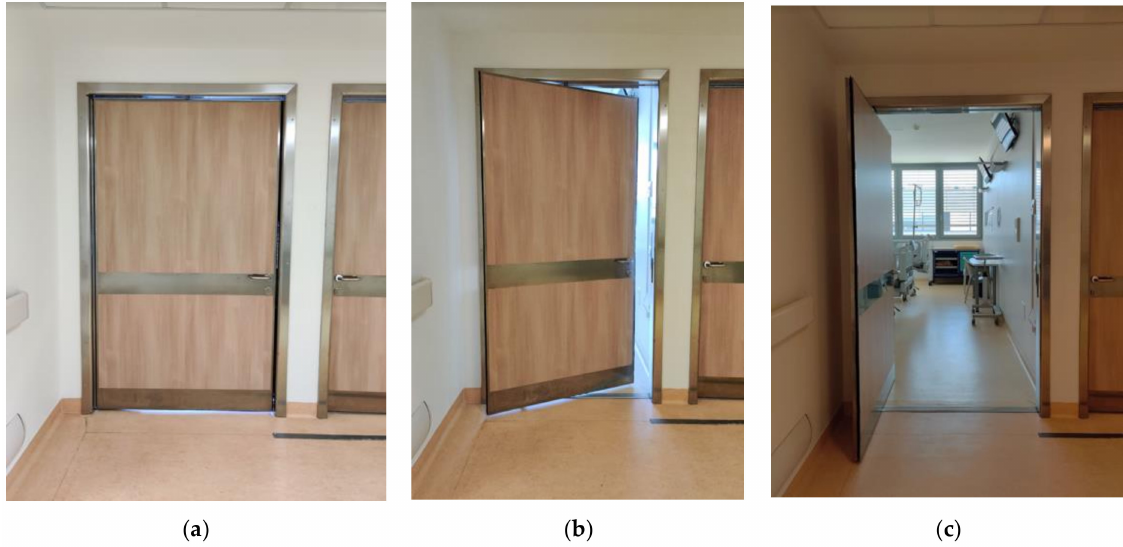
Figure 3. The three configurations of the door: ( a ) closed, ( b ) half-open, and ( c )